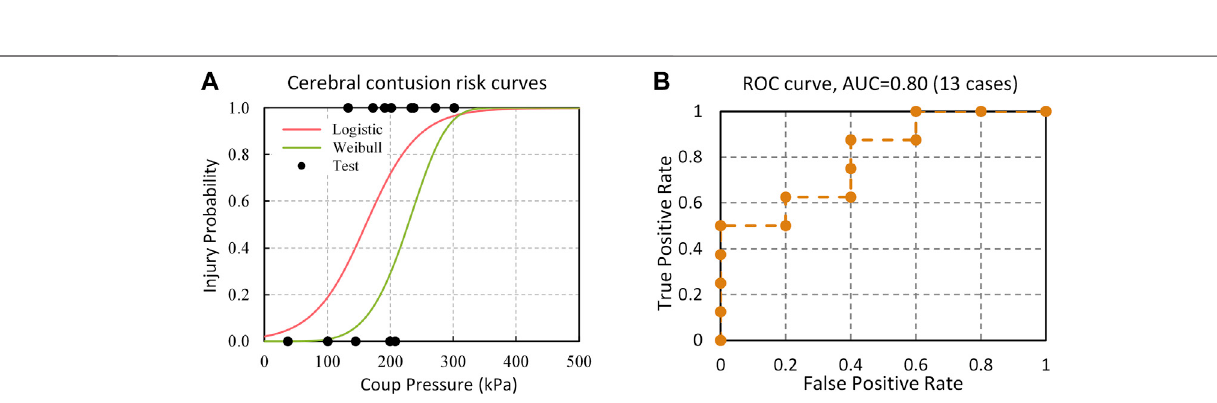
FIGURE 9 | (A) Injury risk curves of cerebral contusion based on Logistic regression and Weibull survival analysis models; (B) ROC curve of contusion injury predictive data.